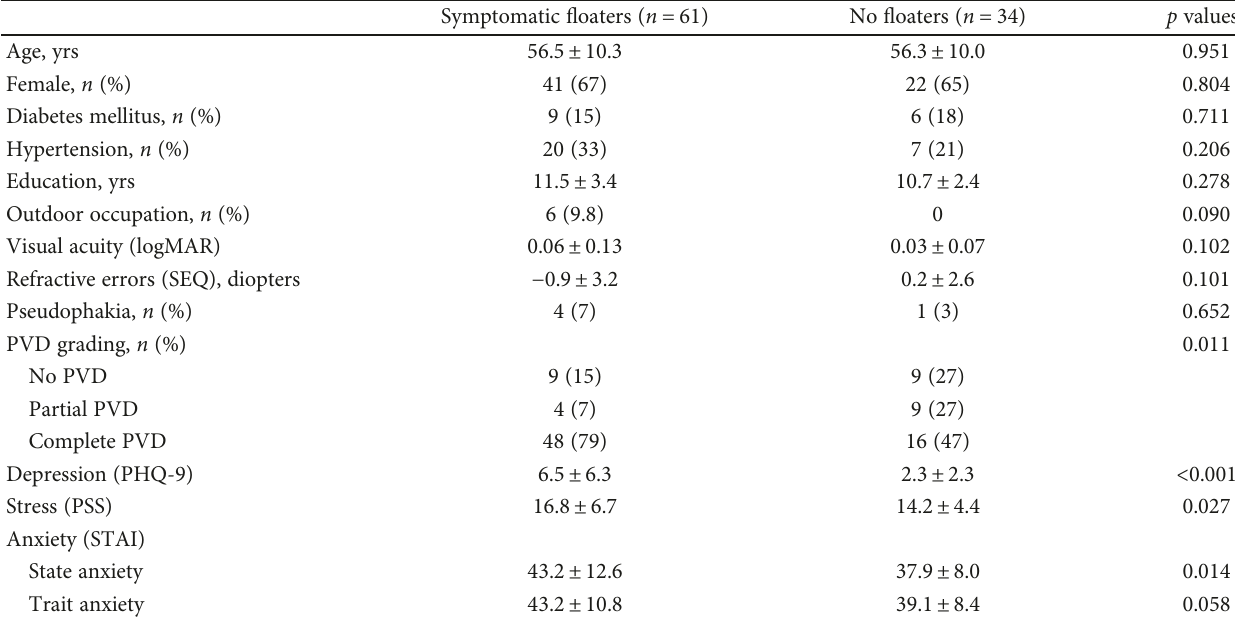
Table 1: Comparison of demographics, posterior vitreous status, and psychologic parameters between patients with symptomatic fl oaters and control.